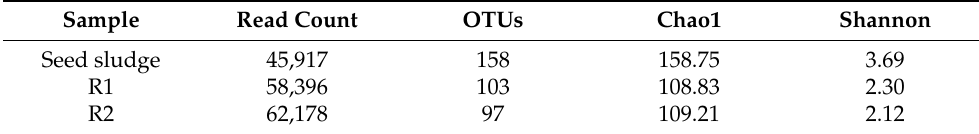
Table 1. Analytical results of the microorganism gene libraries obtained from NGS.